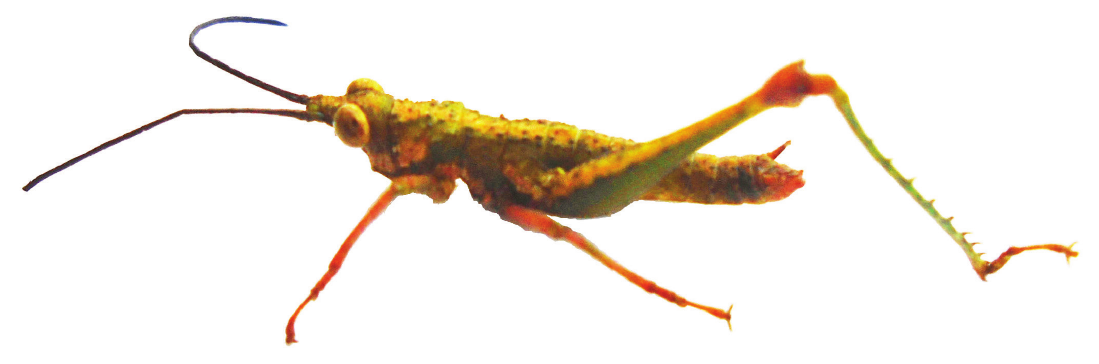
Fig. 5. G. opilionoides , male from Ngutadjap, Cameroon (2°42'N,